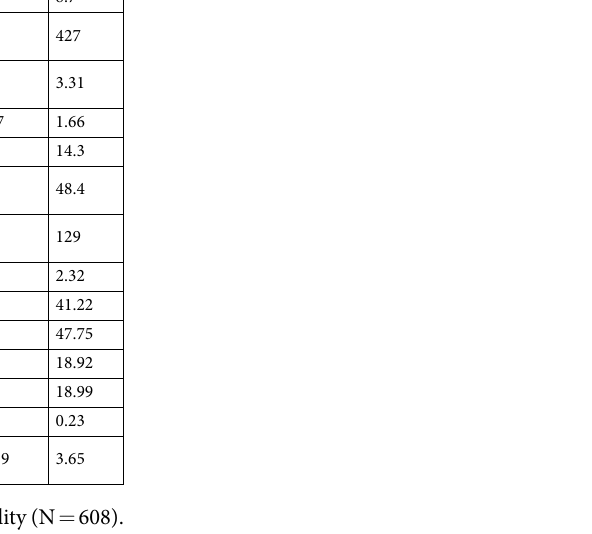
Table 1. Statistical summary of water quality (N =